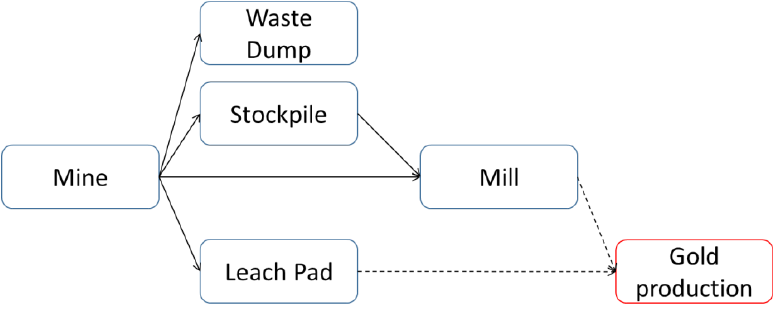
Figure 5. Flow diagram of the mine complex configuration. Table 1. Main parameter used in the optimization.